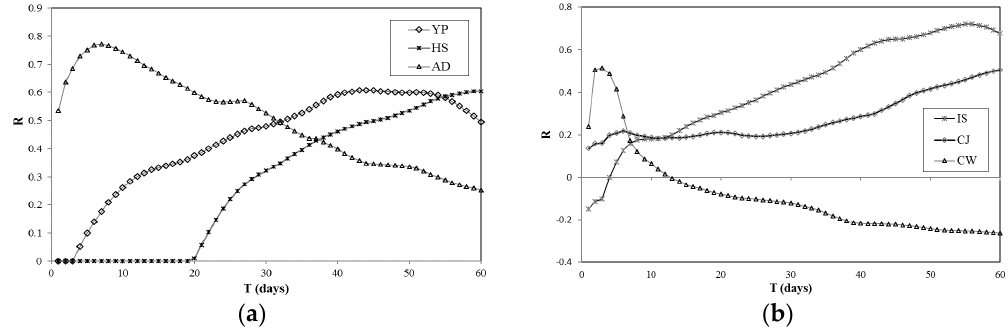
Figure 3. Correlation coefficient ( R ) pattern for different values of characteristic time length ( T days) at six sites: ( a ) YP, HS, and AD; and ( b ) IS, CJ, and CW.